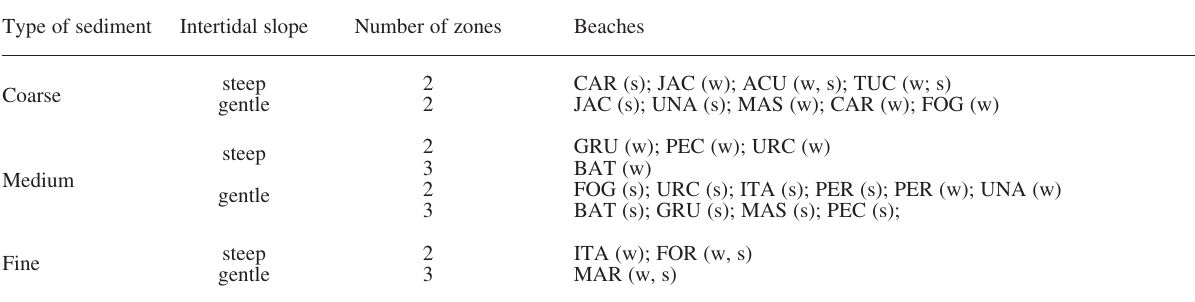
T ABLE 7. – Number of zones formed in beaches studied in relation to grain size and intertidal slope. Beach slope – values < 1/10m are considered steep while those > 1/10m are considered gentle. w – winter, s –